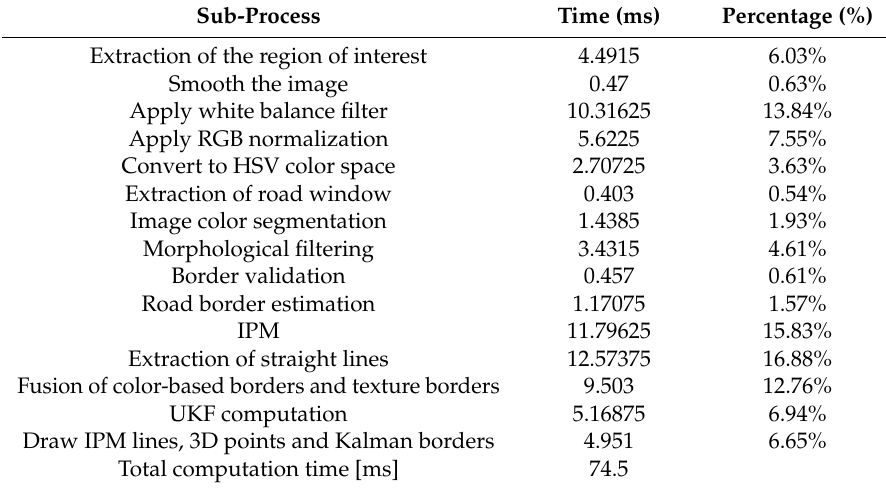
Table 3. The required computation time for image